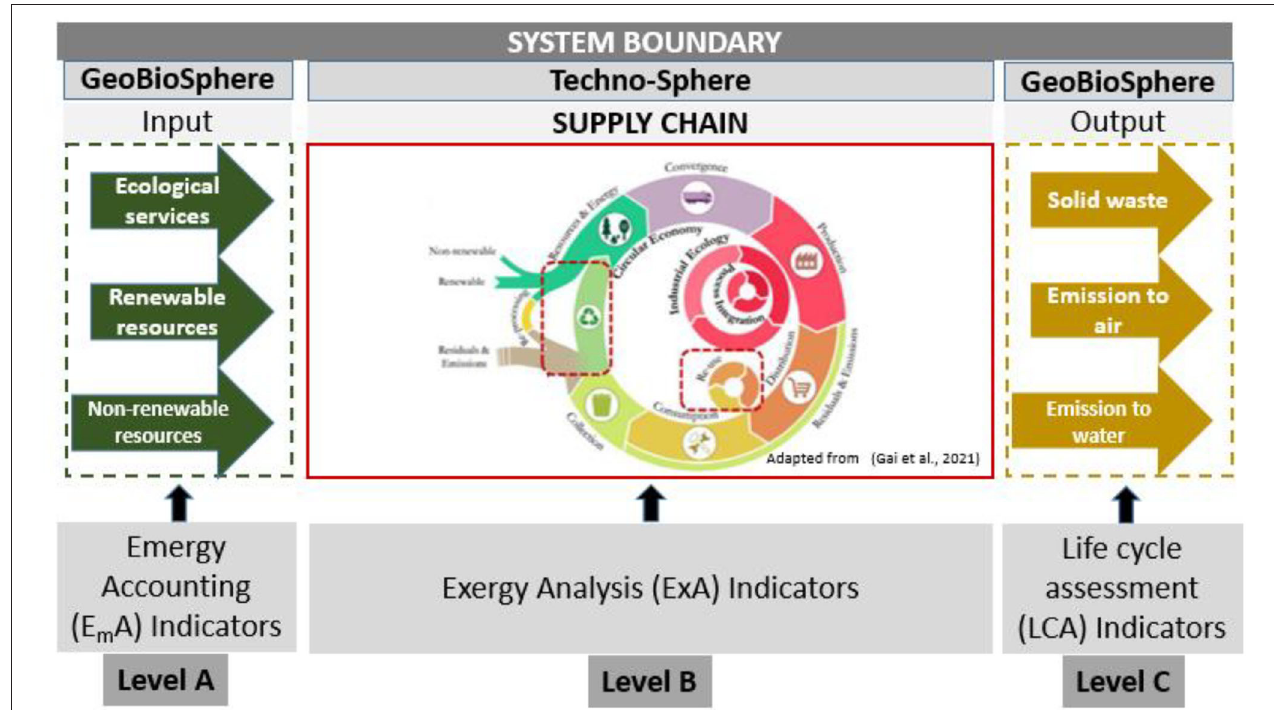
FIGURE 1 | Sustainability integration evaluation by Life Cycle Assessment (LCA), Exergy Analysis (ExA) and Emergy Accounting (EmA) (Modified from Cano et al., 2021).